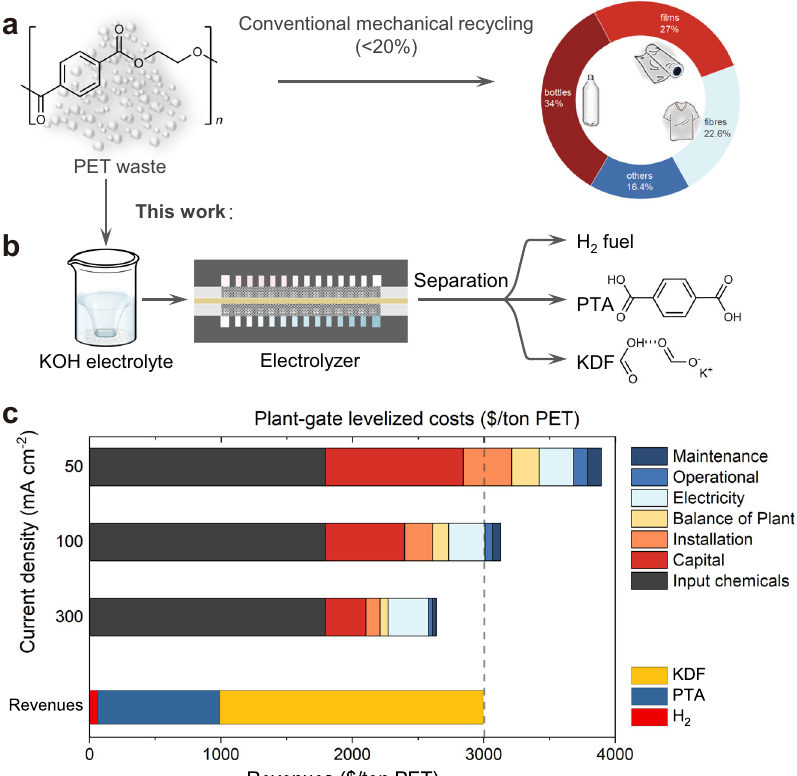
Fig. 1 Conceptual design. a Conventional route for PET recycling. b Electrocatalytic PET upcycling to commodity chemicals and H 2 fuel (Route I). c Techno- economic analysis (TEA) of Route I at different current